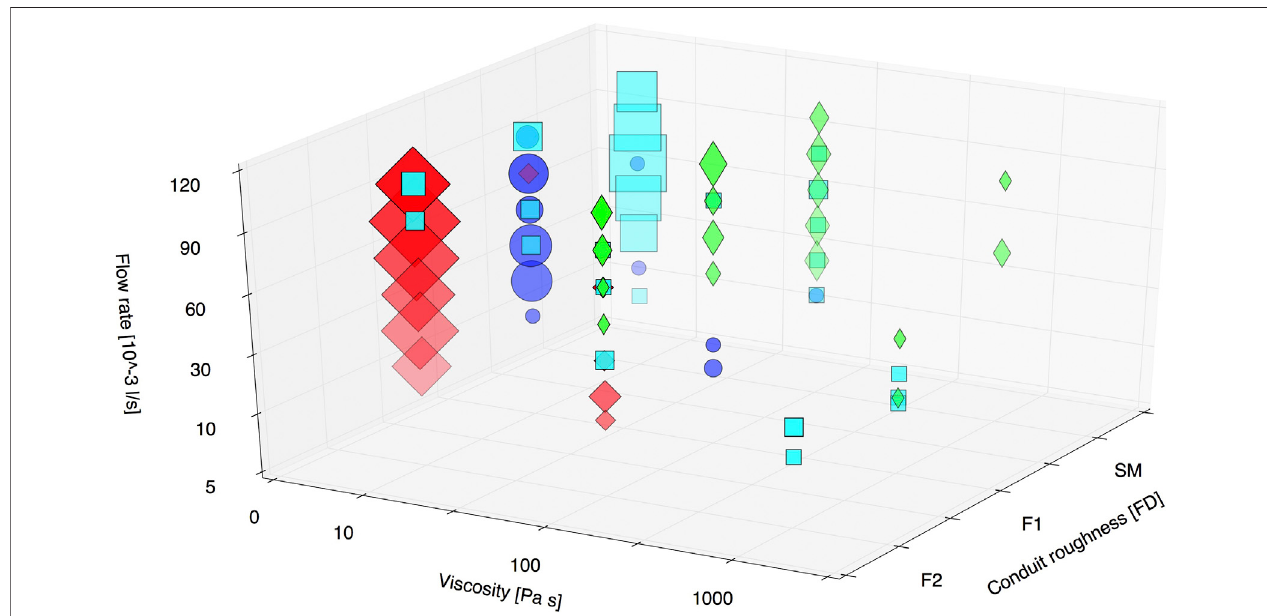
FIGURE 9 | Overall picture of the distribution of events belonging to the four main clusters with respect to the viscosity of the analogue magma, roughness of the analogueconduitandthe fl owrate.Cluster1isindicatedincyan(squares),Cluster2inblue(circles),Cluster3inred(diamond)andCluster4ingreen(thindiamond).The size of the squares is proportional to the number of events that share the same viscosity, roughness and fl ux values and belong to the same cluster.